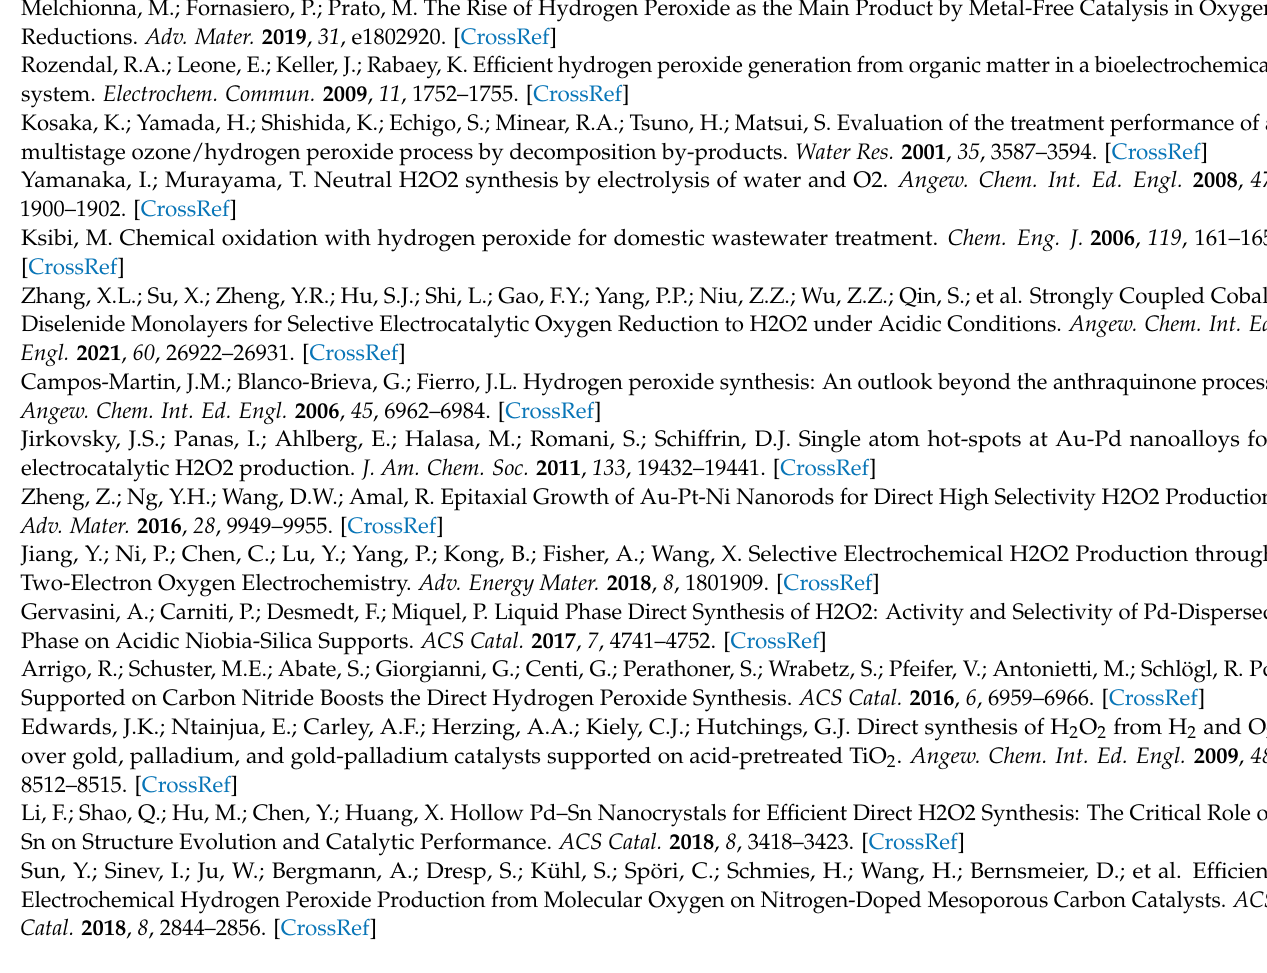
Au: Yellow; Figure S2: Free energy diagrams of 2e − and 4e − ORR on ( a ): Fe 1 @GDY; ( b ): Cr 1 @GDY; ( c ): Ru 1 @GDY; ( d ): Os 1 @GDY; Figure S3: Limiting potentials of 4e − ORR on TM 1 @GDY (TM = Cr, Fe, Co, Ni, Cu, Ru, Pd, Os, and Pt) catalysts. The red line represents the equilibrium potential of 4e − ORR.; Figure S4: The adsorption structure of OOH* on Pt 1 @GDY and the O–O bond length; Table S1: The E b on TM 1 @GDY; Table S2: The G OOH* on TM 1